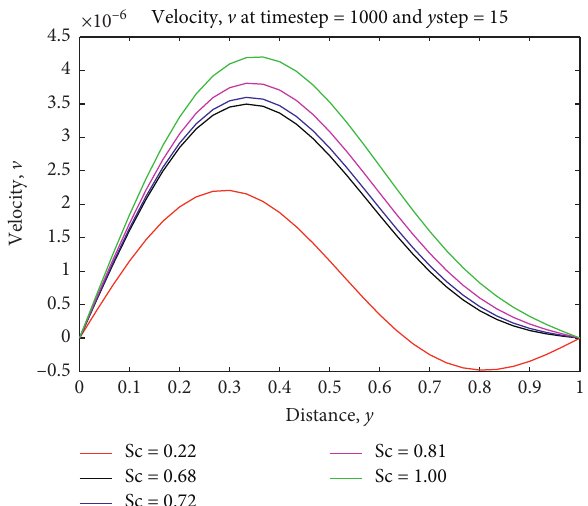
Figure 7: Effects of Schmidt number on secondary velocity profile.